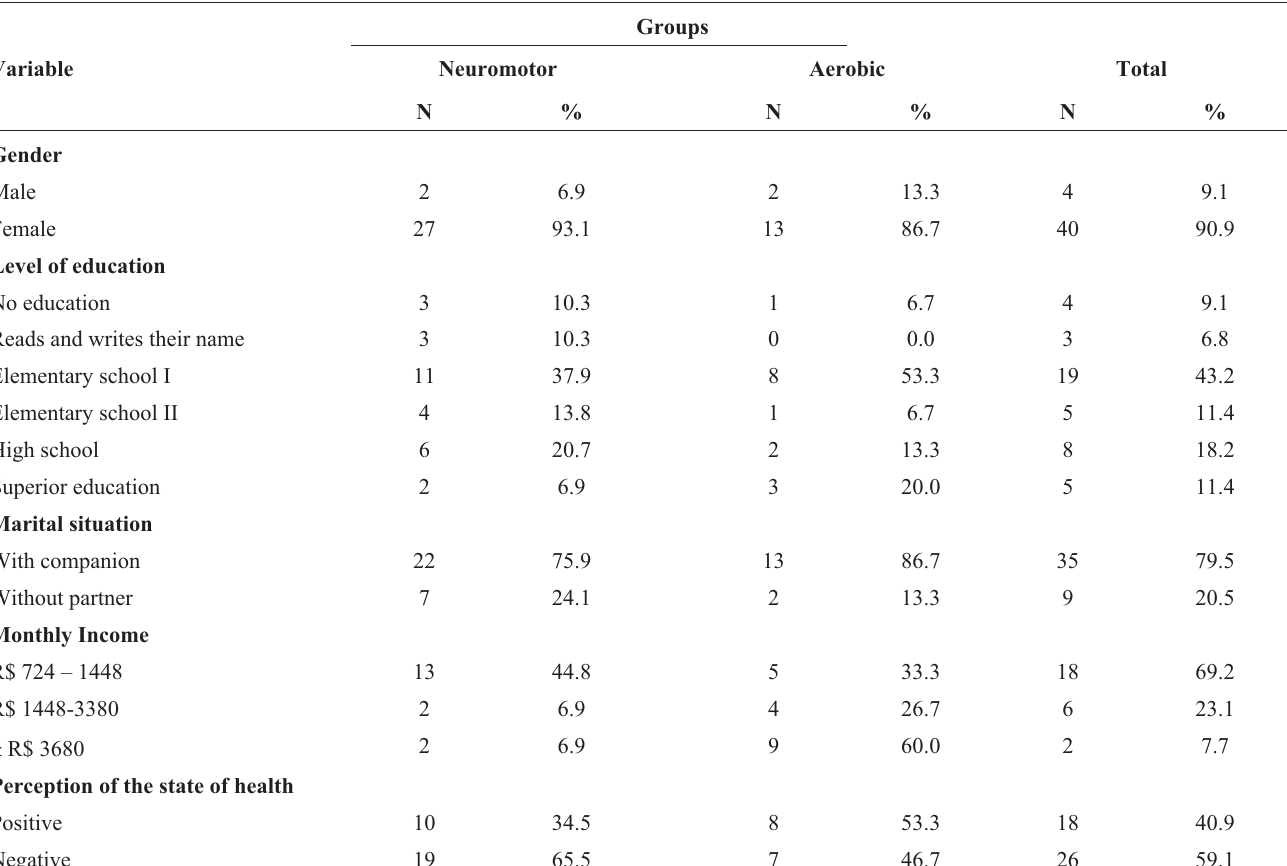
Table 1 - Characterization of participants per group. Jequié-BA, 2015.